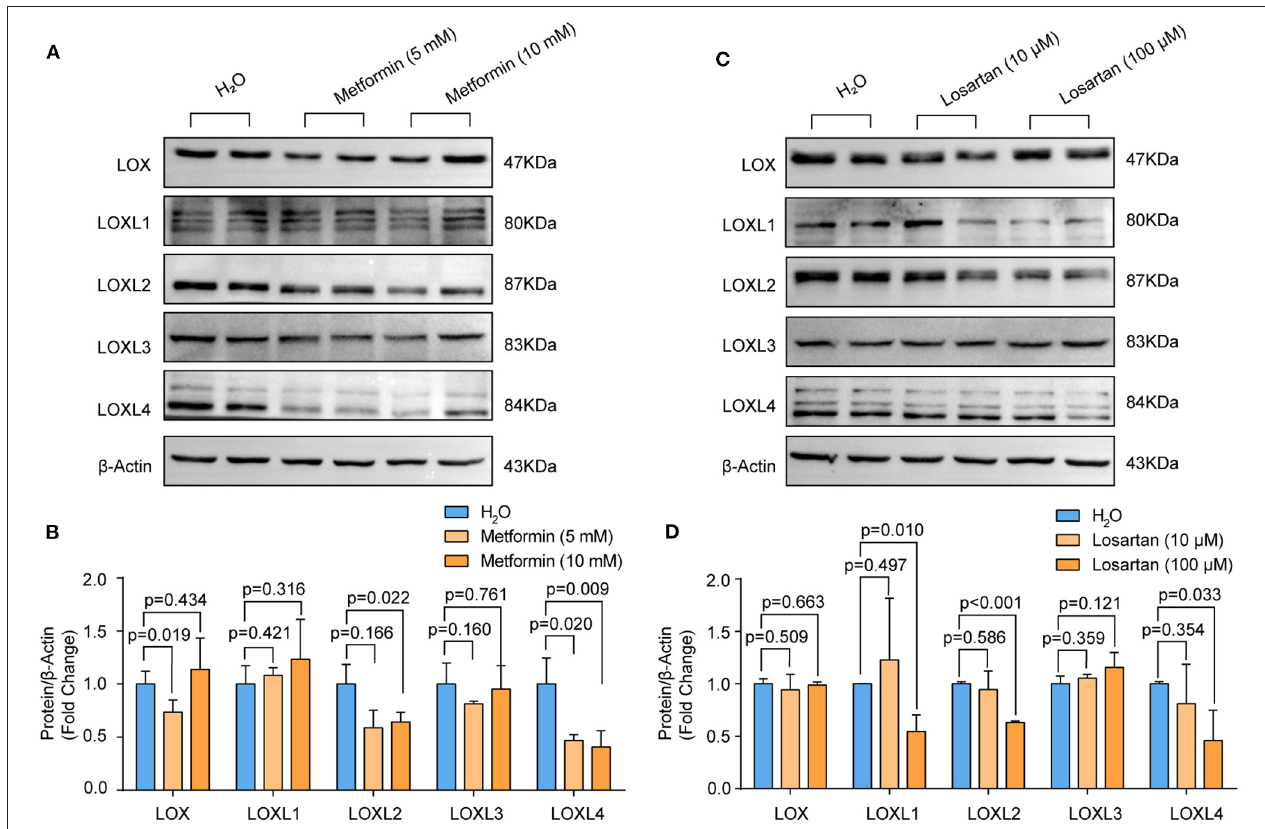
FIGURE 5 | The protein levels of LOXs in primary cultured HASMCs treated with metformin or losartan. (A,B) The protein levels of LOX, LOXL1, LOXL2, LOXL3, and LOXL4 in HASMCs stimulated with 5 or 10mM metformin were evaluated by western blotting ( n = 4). (C,D) LOX, LOXL1, LOXL2, LOXL3, and LOXL4 protein levels in HASMCs treated with 10 or 100 µ M losartan were detected by using western blotting ( n = 4). H 2 O-treated HASMCs served as the control group in (A) and (B)